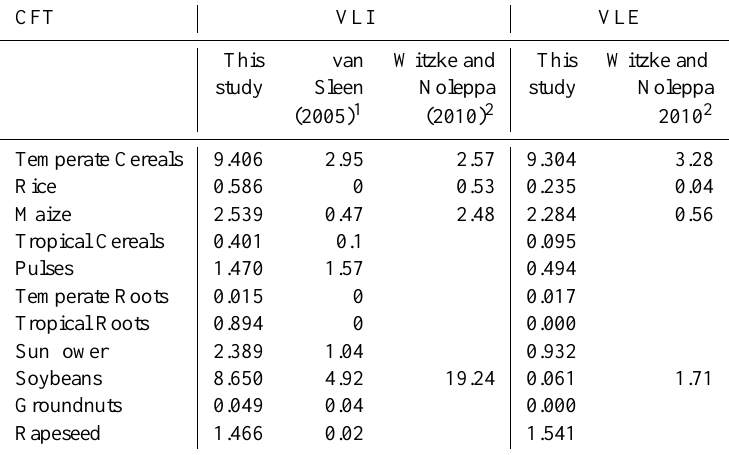
Table A2. Comparison of virtual land flows with other estimates. All values in Mha. CFT VLI VLE